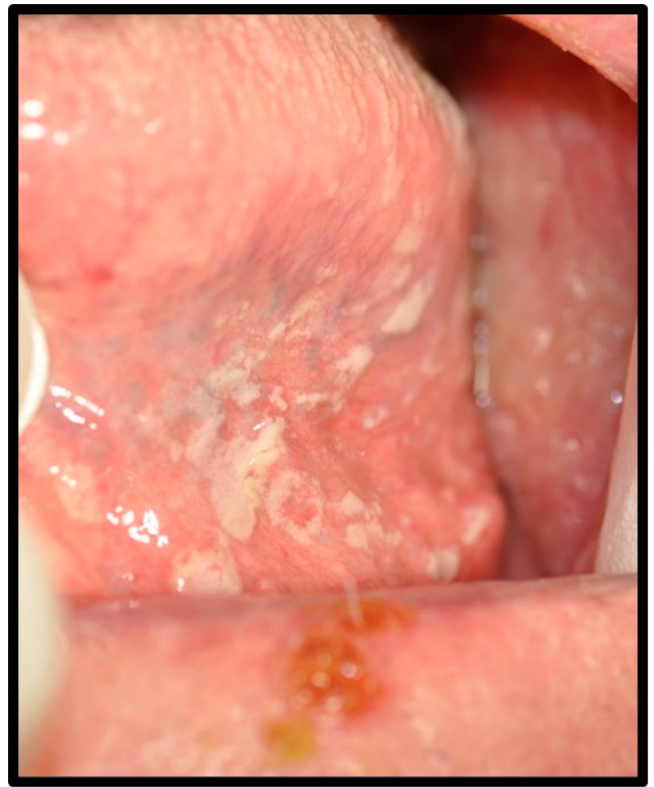
Figure 5. Oral pseudomembranous candidiasis, with positive Candida albicans, on the ventral and lateral tongue. The patient, on pembrolizumab, presented with xerostomia and dysphagia. Herpes labialis was also seen on the lower lip.